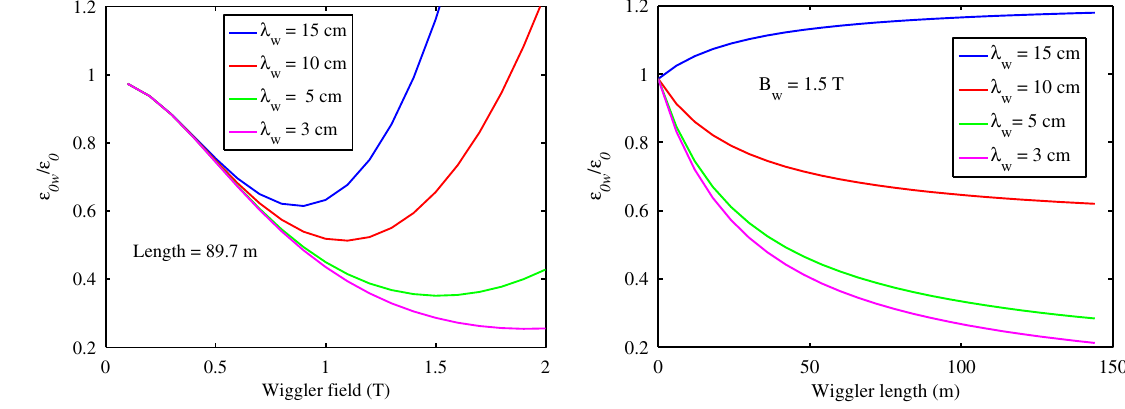
FIG. 9. Relative emittance reduction versus wiggler field (left) and versus wiggler length (right) for various values of wiggler period.